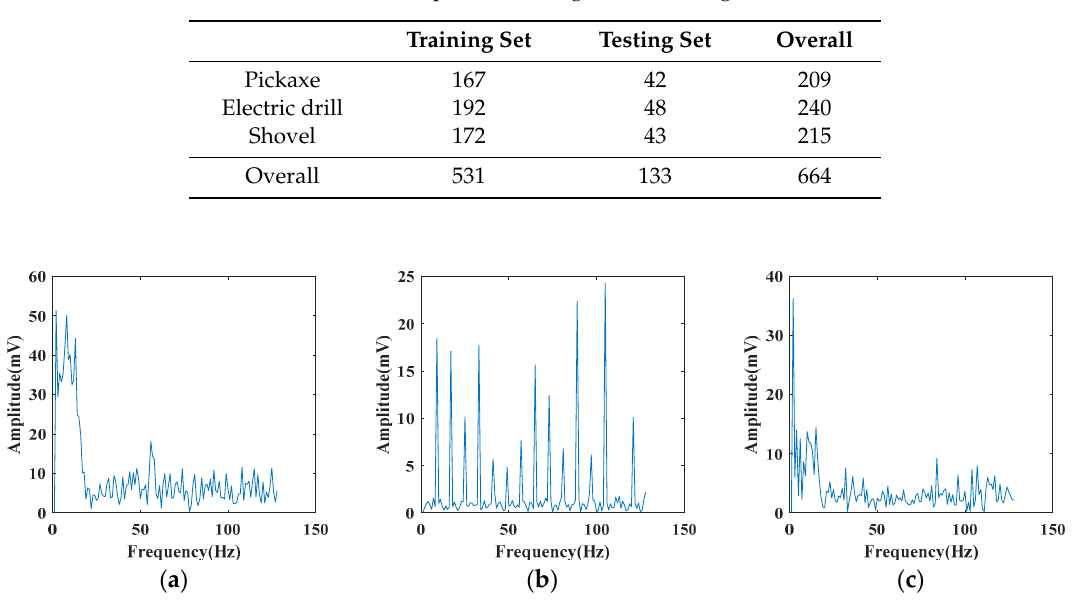
Figure 7. Fiber vibration signals in frequency domain: ( a ) pickaxe; ( b ) electric drill; ( c ) shovel.